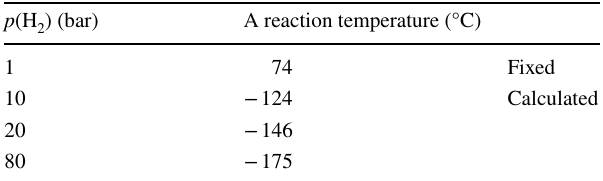
2 BH 3 at different